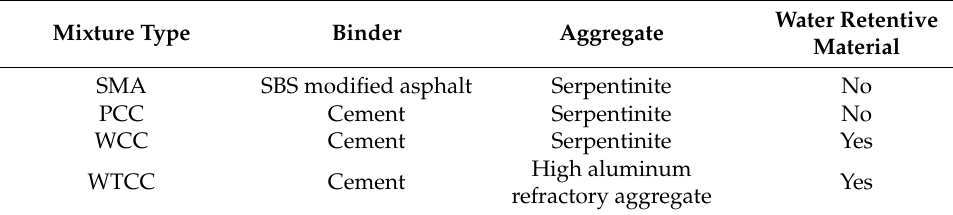
Table 1. Brief of the composition of different mixtures.